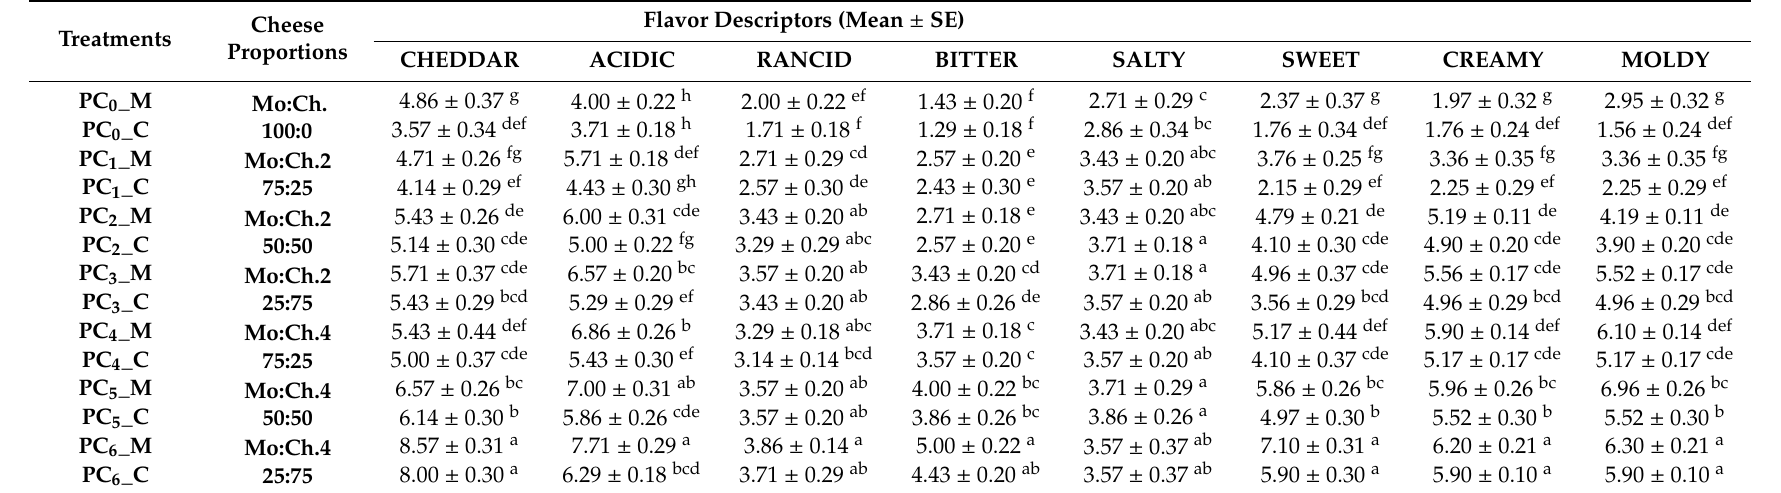
Table 3. E ff ect of cheese proportions, ripening time (months), of Cheddar cheese and cooking methods on the flavor descriptors of Pizza cheese. Flavor Descriptors (Mean ± SE) Cheese Treatments Proportions CHEDDAR ACIDIC RANCID BITTER SALTY SWEET CREAMY